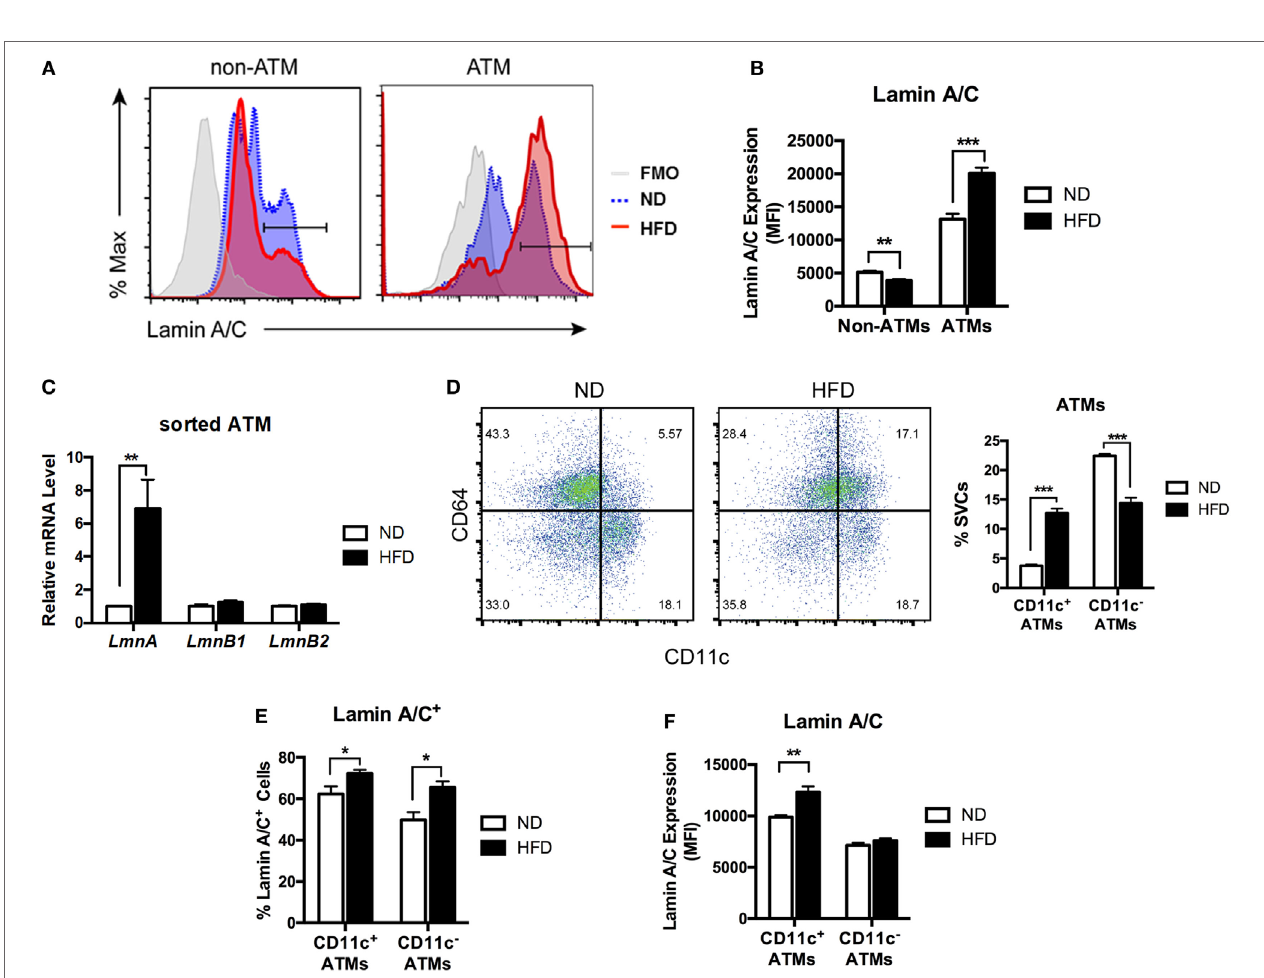
FigUre 1 | Lamin A/C expression is upregulated in adipose tissue from obese mice. (a–e) Male C57BL/6 mice were fed a normal chow diet (ND) or a high-fat diet (HFD) for 12 weeks to induce obesity ( n = 14 per group). (a) Total body weights (left) and organ weights (right), (B) fasting blood glucose, (c) glucose tolerance test, and (D) quantitative real-time RT-PCR (qRT-PCR) analysis of Lmna , Lmnb1 , and Lmnb2 in eWAT, iWAT, and liver from ND- and HFD-fed mice. Amounts of transcripts for each gene in HFD tissues relative to those in ND tissues are presented. (e) Western blotting analysis of epididymal white adipose tissues (eWAT) lysate from ND- and HFD-fed mice. Lamin A/C (upper), lamin B1 (middle) protein levels are presented. Equal amount of total proteins as measured by Ponceau S staining (lower) of each lane. (F) qRT-PCR analysis of Lmna, Lmnb1, and Lmnb2 in eWAT from db/ + and db/db male mice (8 weeks, n = 5 per group). (g) qRT-PCR analysis of Lmna, Lmnb1, and Lmnb2 in eWAT from ob/ + and ob/ob male mice (10 weeks, n = 4 per group). (h) qRT-PCR analysis of Lep, Emr1, Lmna, and Lmnb1 in adipocyte fractions and stromal vascular cell fractions from eWAT of ND and HFD mice ( n = 6 per group). (i) Immunoblots of lysates from the stromal vascular fraction (SVF) of eWAT from ND and HFD mice for lamin A/C antibody (upper left), Ponceau S staining (lower left) and quantitation of lamin A/C (right) were presented. Error bars represent SEM. * p < 0.05, ** p < 0.01, *** p <